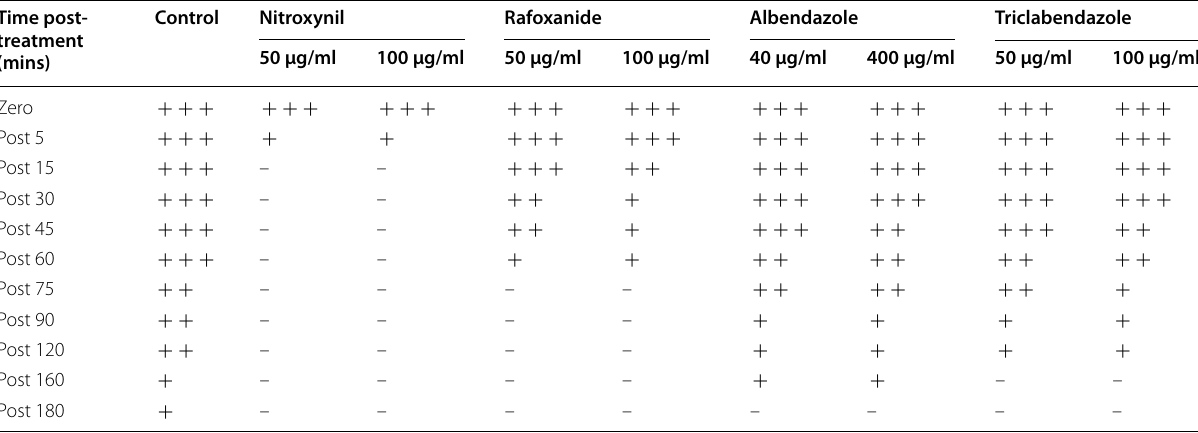
Table 1 The effect of flukicides on the motility of Fasciola gigantica adult